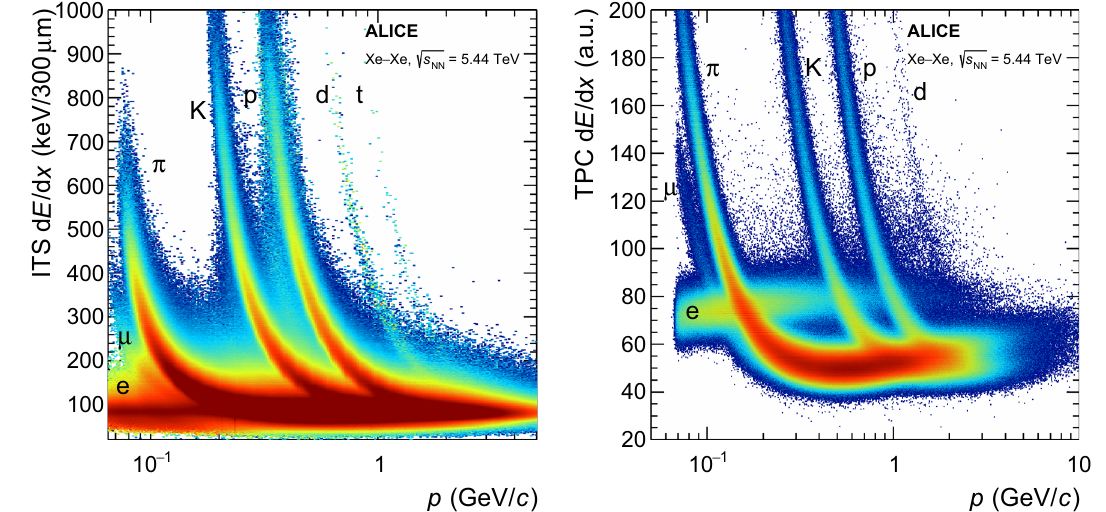
Fig. 1 Distribution of the d E / d x measured in the ITS (left) and TPC (right) detectors as a function of the reconstructed track momentum in √ s NN = 5 . 44 TeV. The bands corresponding to the Xe–Xe collisions at